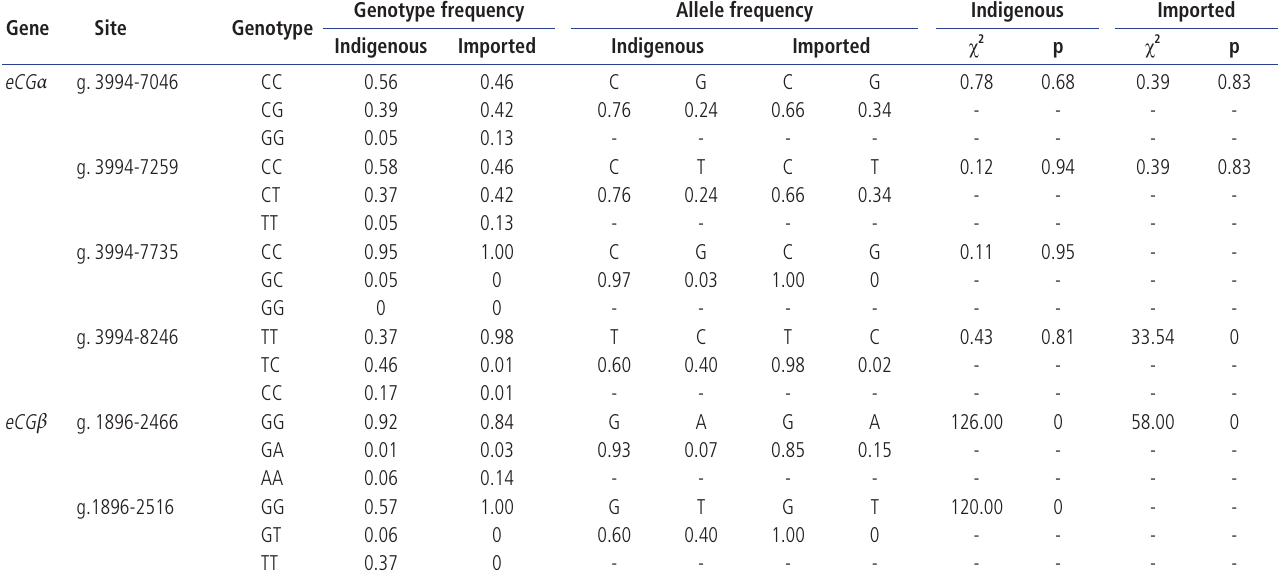
Table 2. Polymorphisms in the 5’ UTR of eCG genes Genotype frequency Allele frequency Gene Site Genotype